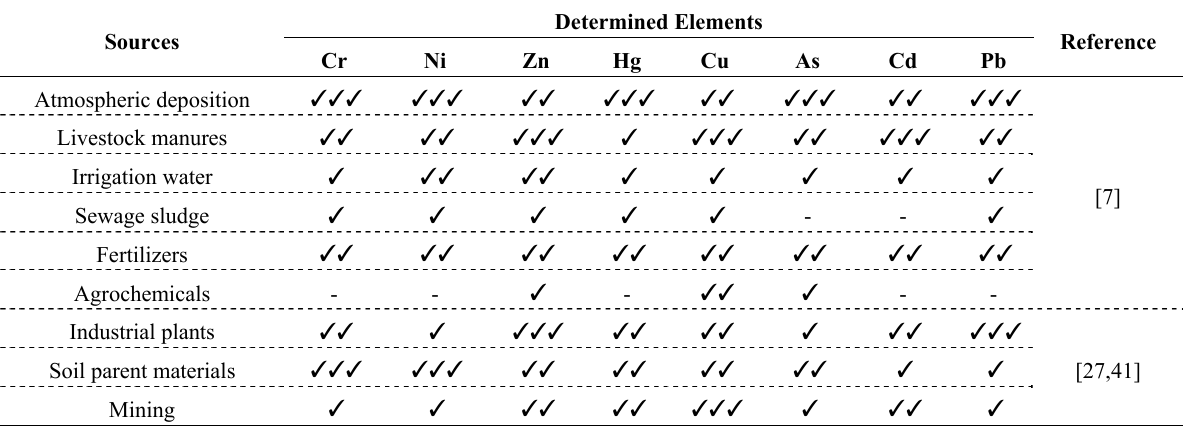
Table 1. The contribution and the rank of sources to heavy metals in soils.